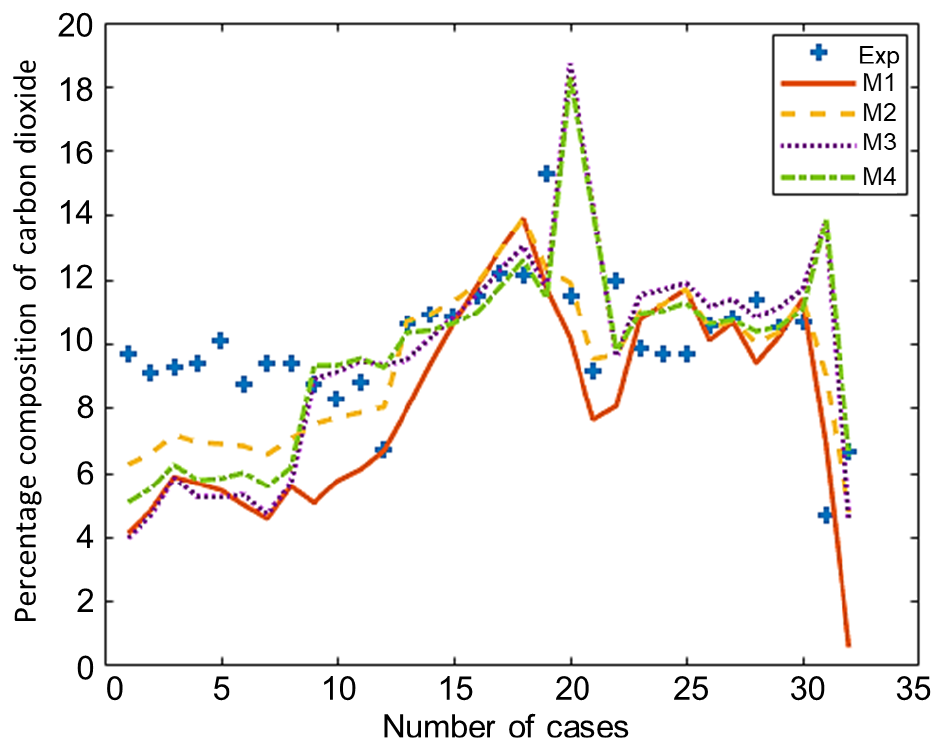
Figure 5. Comparison of carbon dioxide composition given by experiments and models.